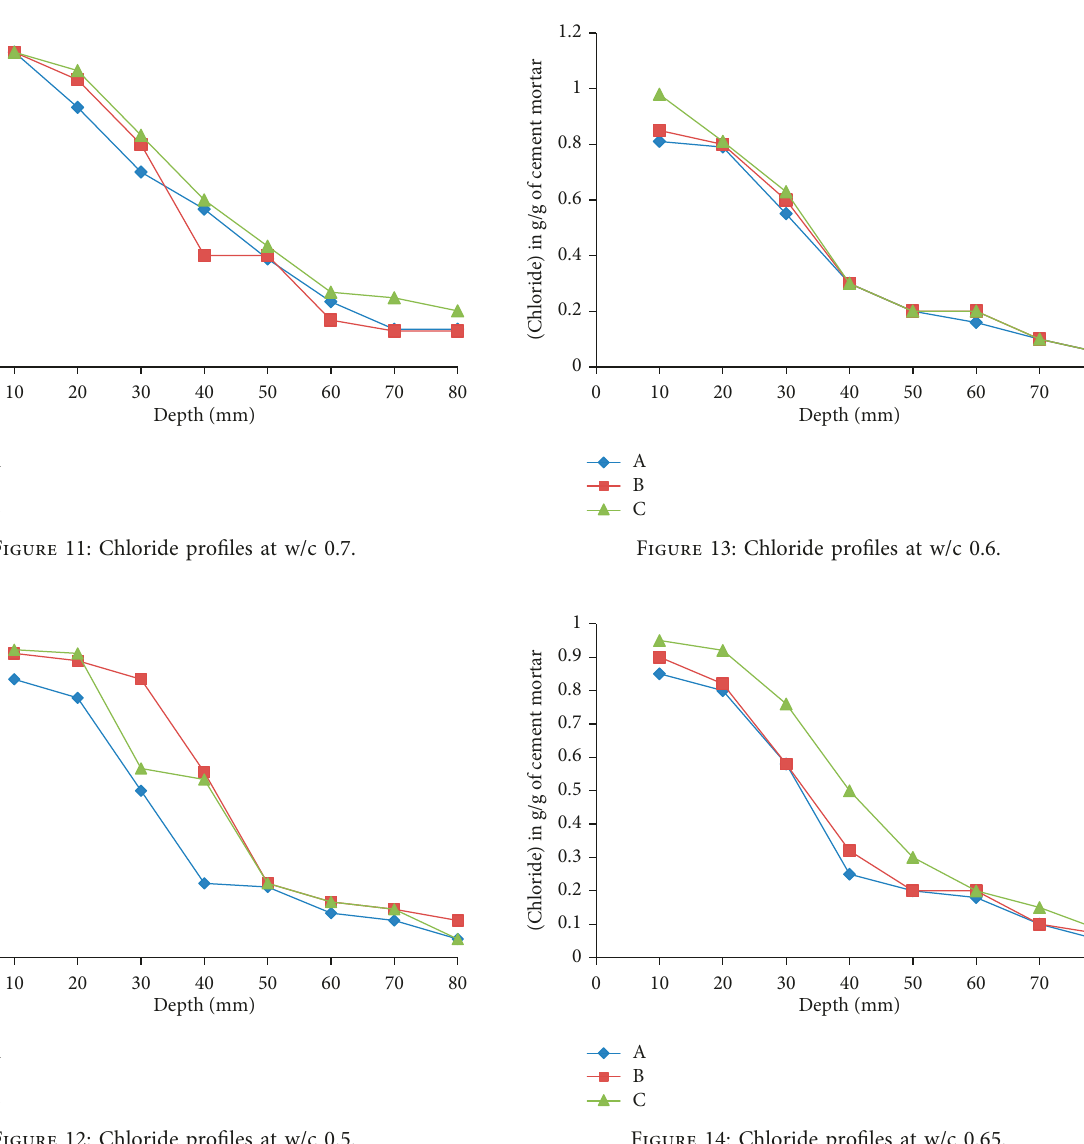
Figure 14: Chloride profiles at w/c